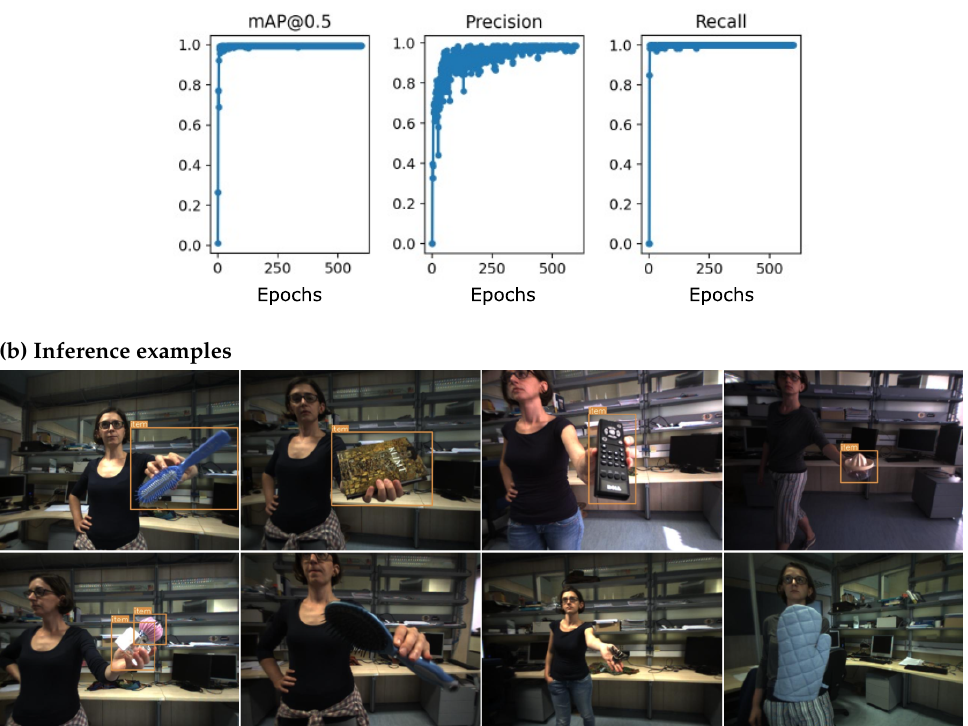
Figure 10. Results on the iCubWorld dataset using the Scaled-YOLOv4-p5 model. The model was trained for 200 epochs. Panel ( a ): The metrics (mAP@0.5, recall, and precision) on the validation datasets are calculated after each epoch and reach high values after only a few epochs. For more details see Figure A2. Panel ( b ): Inference examples on the iCubWorld test dataset at epoch 175. Most objects are detected well, some are not detected at all (5 out of 82). In contrast to Faster R-CNN, there are only few cases where multiple bounding boxes have been detected (1 out of 82) and bounding boxes are more accurate with only rarely missing parts of the object (8 out of 82), even though (P1) and (P2) are not